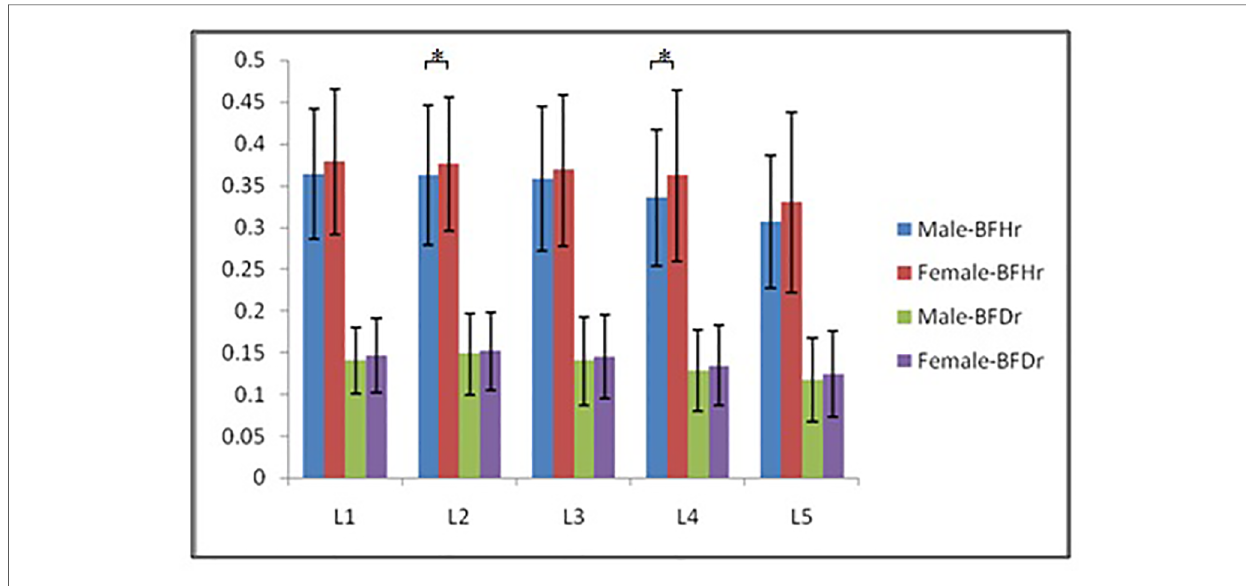
FIGURE 7 Females have higher BFHr and deeper BFDr than males in lumbar vertebrae, which only BFHr at L2 and L4 show statistically signi fi cant difference.